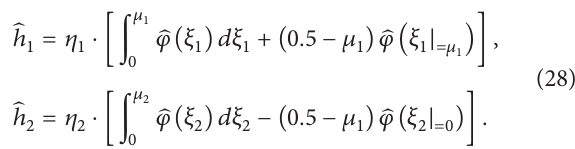
Figure 3: A mechanical model of a discretized cable, damper